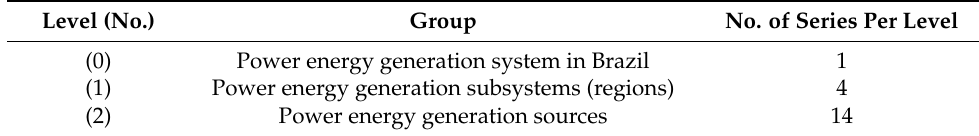
Table 1. Dataset-I: Brazilian power generation hierarchy data structure. Level